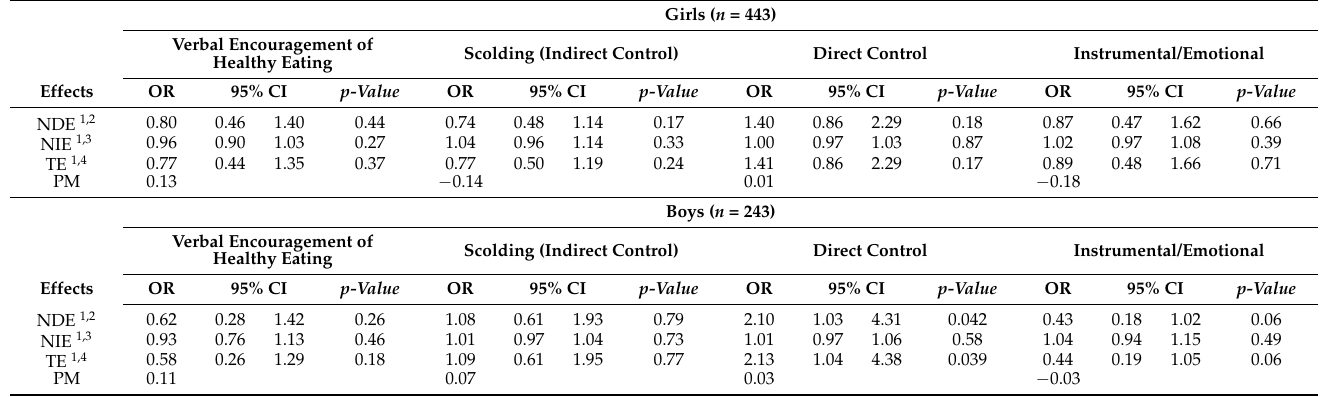
Table 4. Mediation of TCRAD scores in the association between PFS scores and the odds of excess weight stratified by sex in Costa Rican adolescents ( n =